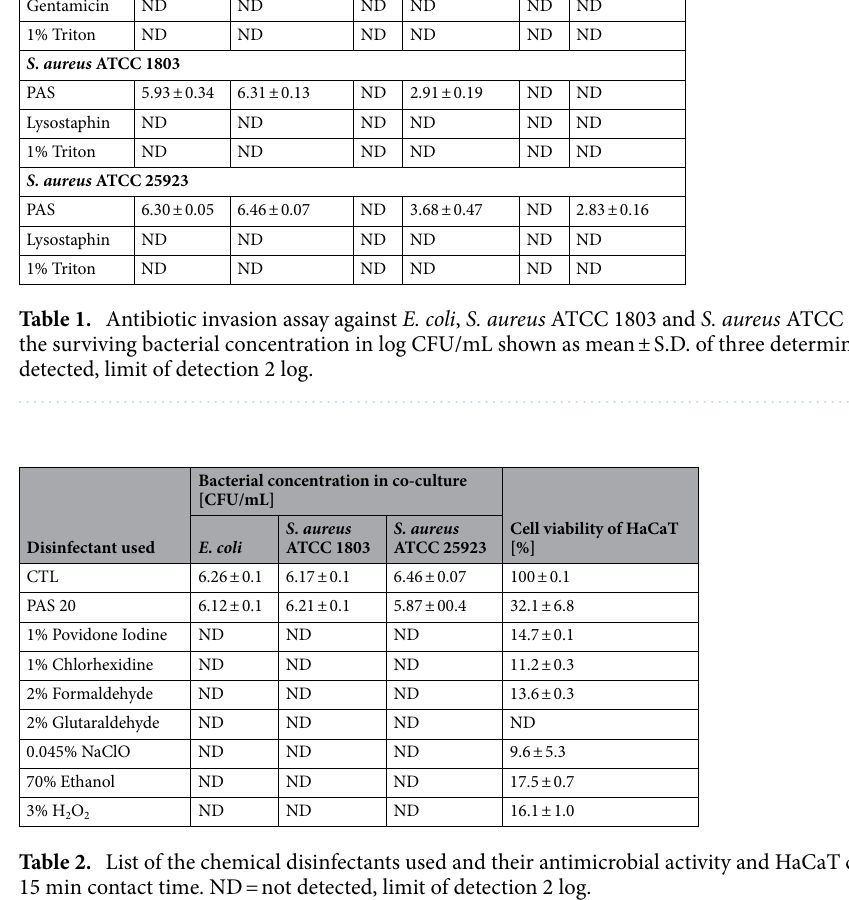
Table 2. List of the chemical disinfectants used and their antimicrobial activity and HaCaT cell viability after 15 min contact time. ND = not detected, limit of detection 2 log.